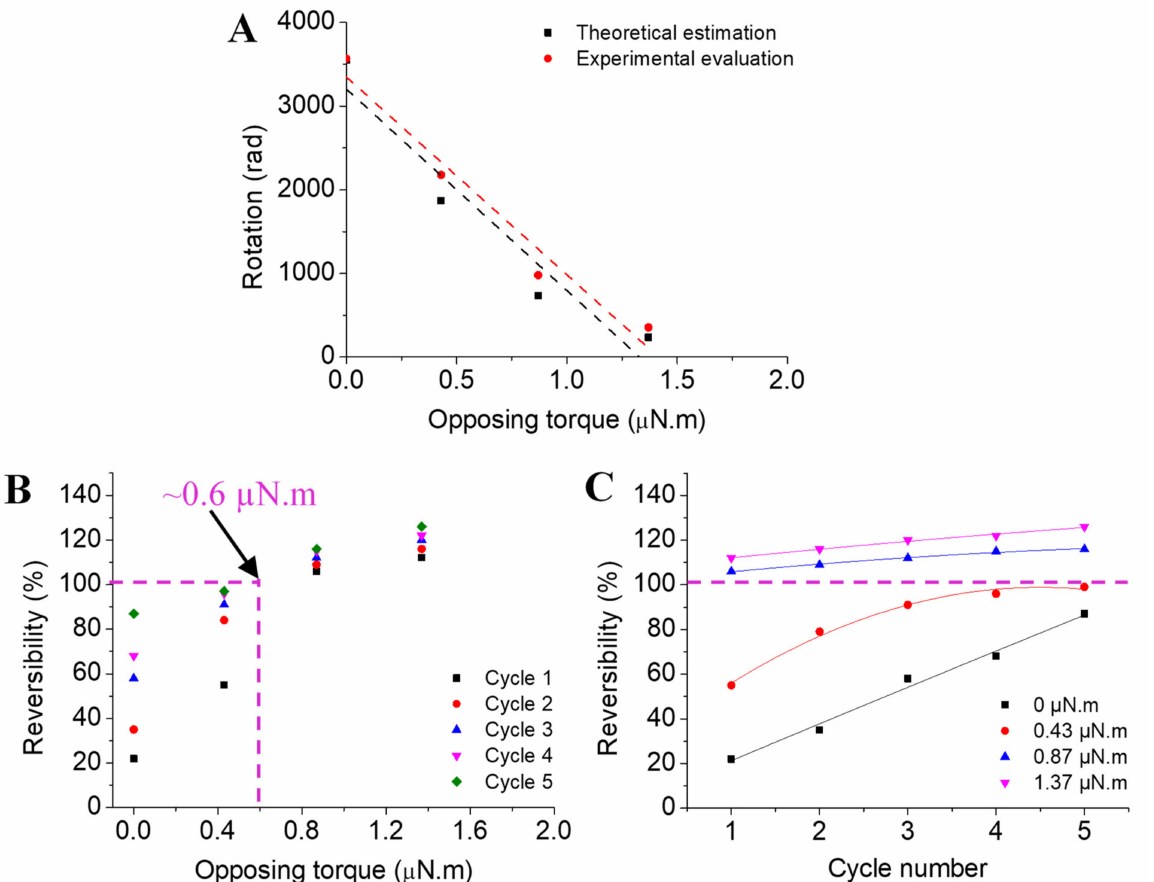
Figure 6. Graphical representation of the method to obtain high reversibility of torsional stroke: ( A ) agreement between theoretically estimated and experimentally measured results; ( B ) reversibility in terms of experimental opposing torque applied by the return spring; ( C ) number of cycles before achieving full